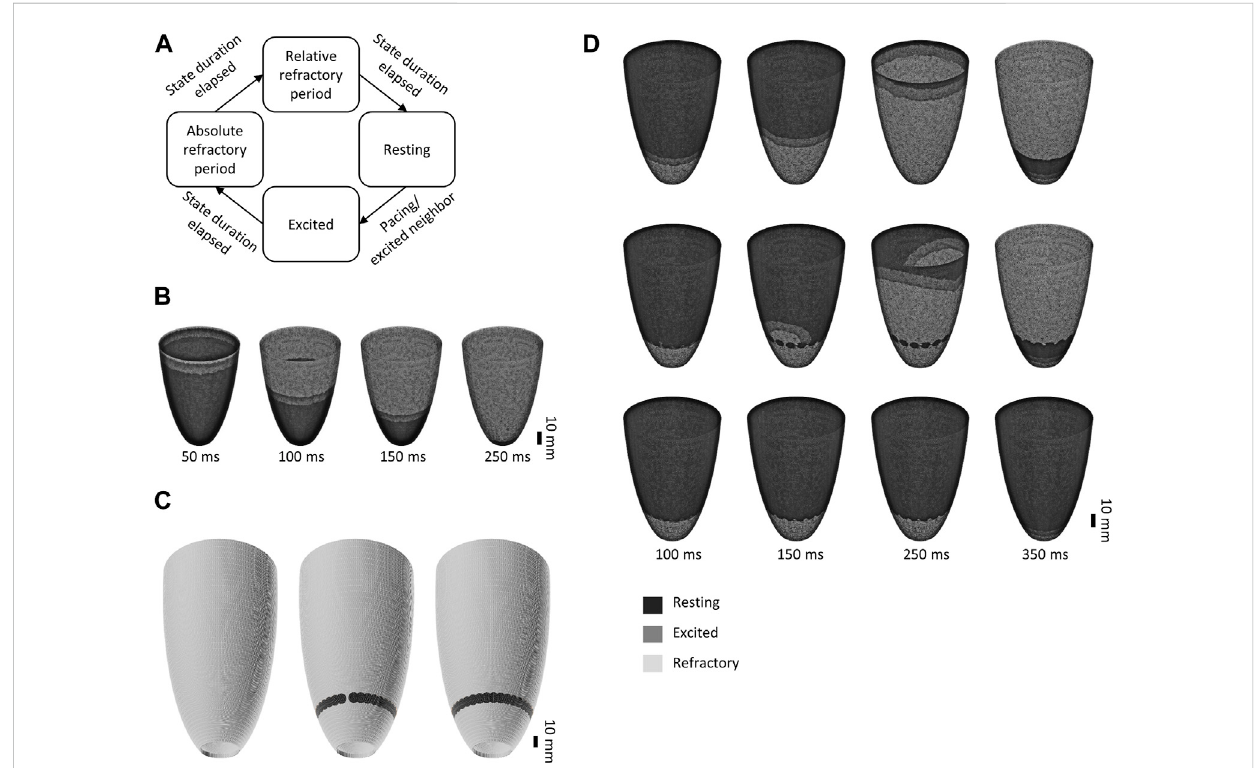
Simpli fi ed two-dimensional in silico model of the left ventricle. (A) . Cell cluster states and state transitions in the fi nite state machine used to generatethemodel. (B) .Electrical propagationduring sinusrhythm(cycle length800 ms). (C) .3Dmeshincorporatingno(left),incomplete(center)anda complete, i.e., continuous set ofablation lesions. (D) . Simulationof VT (cycle length300 ms) originating from the apical LVADinsertion site without (top), with incomplete (center) or with complete (bottom) sets of ablation